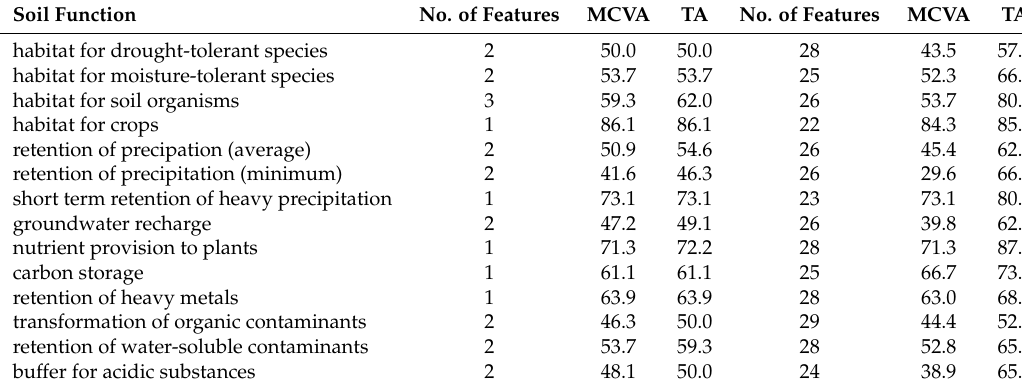
Table 5. Comparison of the evaluation of models using only the features resulting from the feature selection procedure, and models implementing a larger predictor variable set. MCVA = median cross-validated accuracy of 100 model runs, TA = test accuracy (all profile sites are used as model and validation